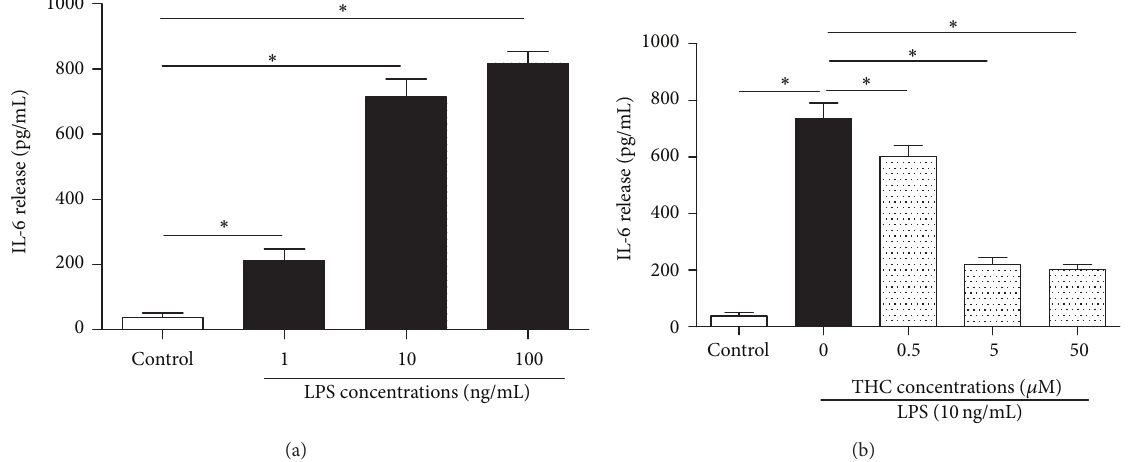
Figure 2: THC decreased LPS-induced IL-6 release from MG-63 cells dose-dependently. (a) MG-63 cells were treated with 0, 1, 10, and 100ng/mL LPS for 24 h. (b) The MG-63 cells were treated with different concentrations of THC plus 10ng/mL LPS for 24 h. IL-6 release was determined by ELISA kits. Results are means ± SD ( 𝑛 = 8 ). ∗ : 𝑃 < 0.05